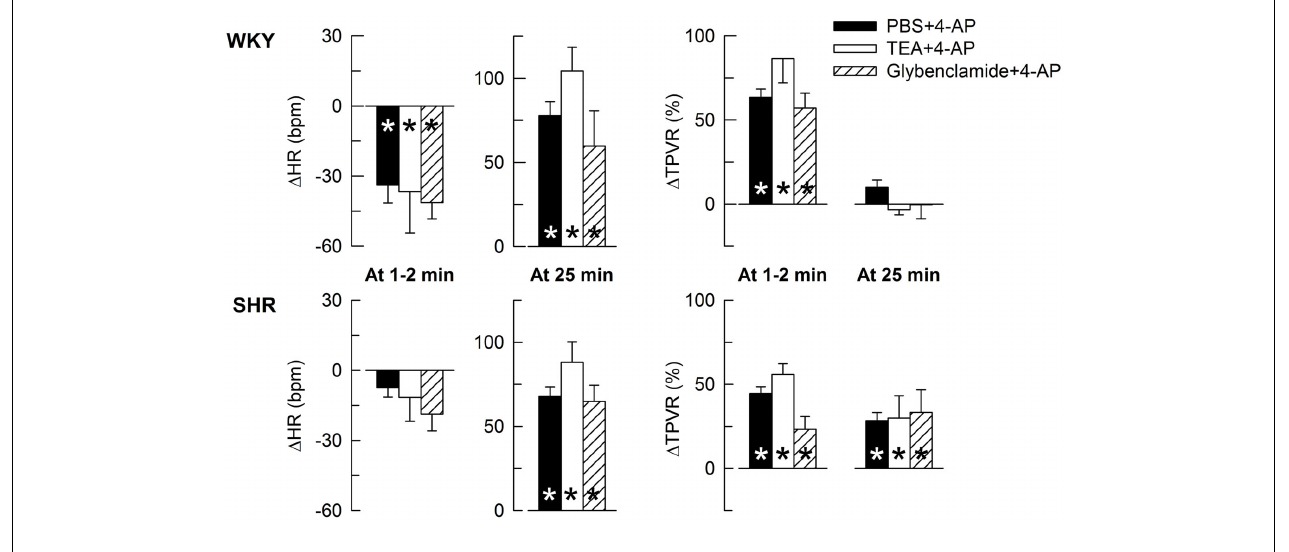
during the initial response and at 25min were subsequently located as indicated (* within symbol). Significant group differences were not detected.The effects ofTEA and glibenclamide on baselines are shown in Table 2 . * – P ≤ 0.025.